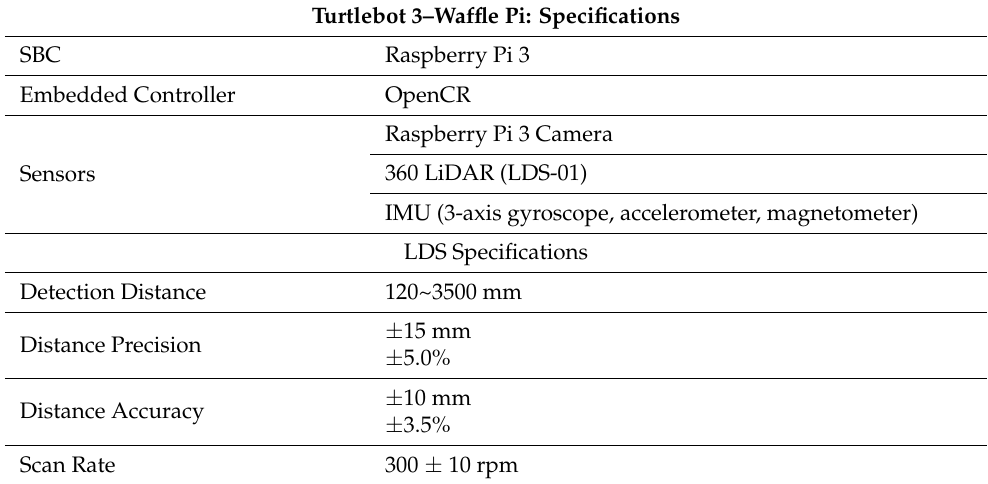
Table 2. Turtlebot 3 and LiDAR Specifications